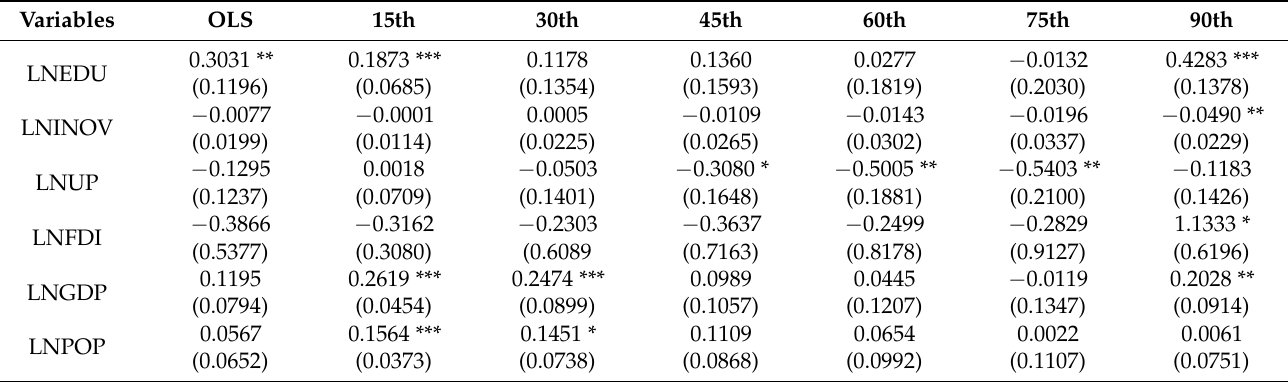
Figure 1. Quantile Distribution for Lower-Middle Income Countries. Table 5. Quantile Regression Results (Upper-Middle-Income